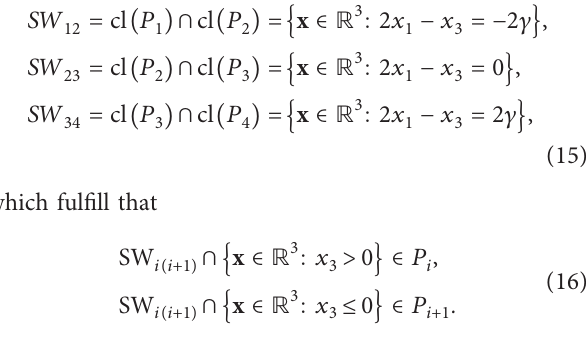
� (− 0 . 9999976751050959 , 0 , − 2 . 3248949041393315 e − 6 ) T (red) and 01 � ( 0 , 0 , 0 ) T and the same parameters. 0